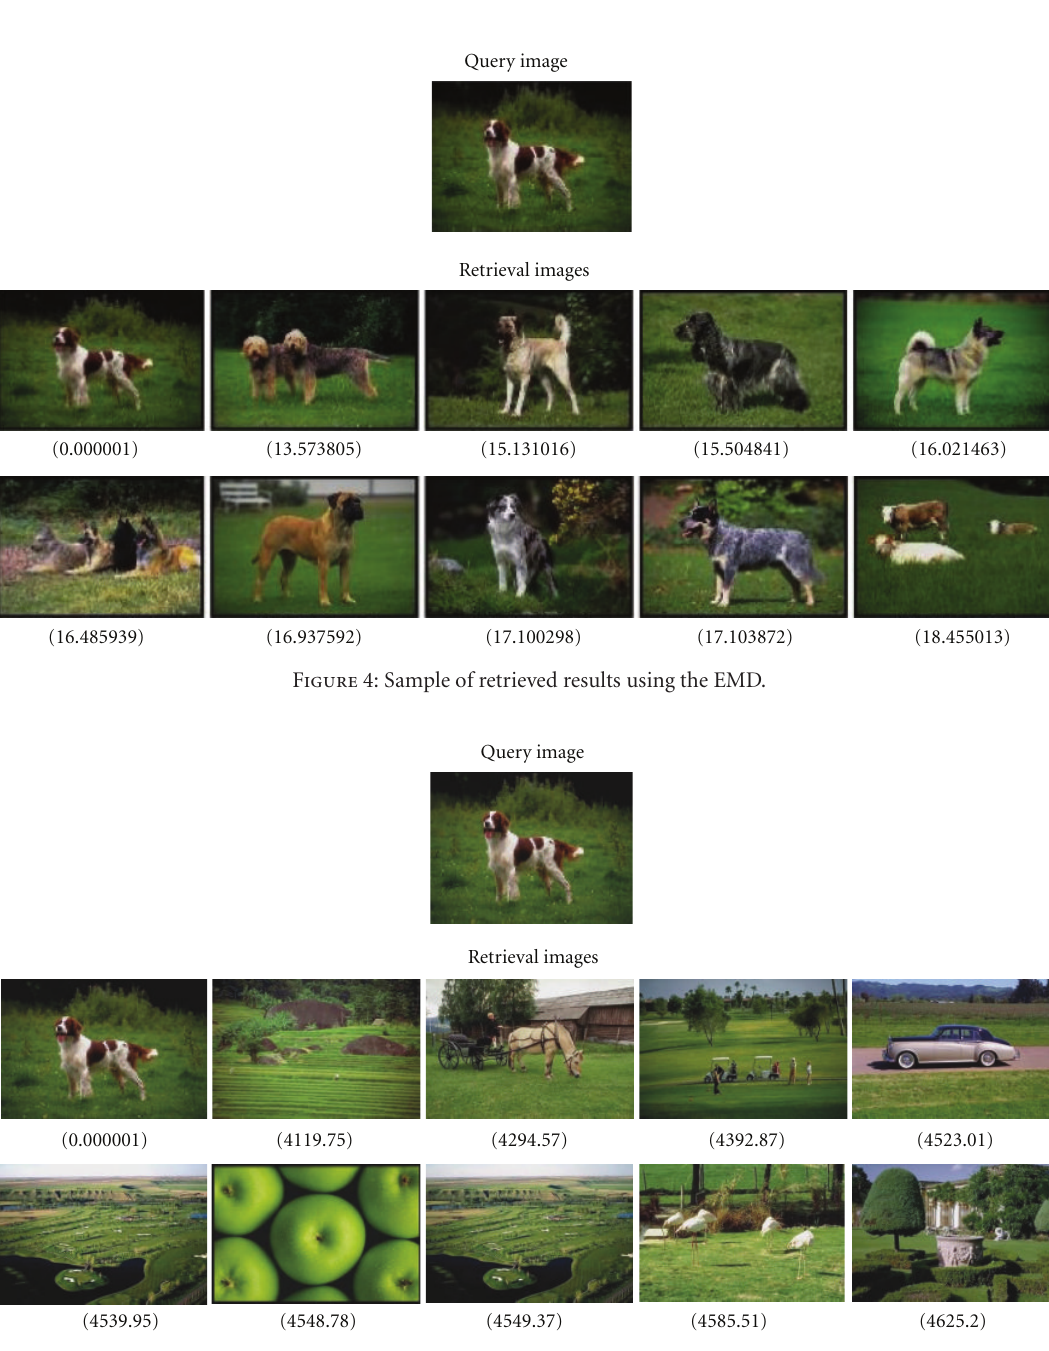
Figure 5: Sample of retrieved results using the L p